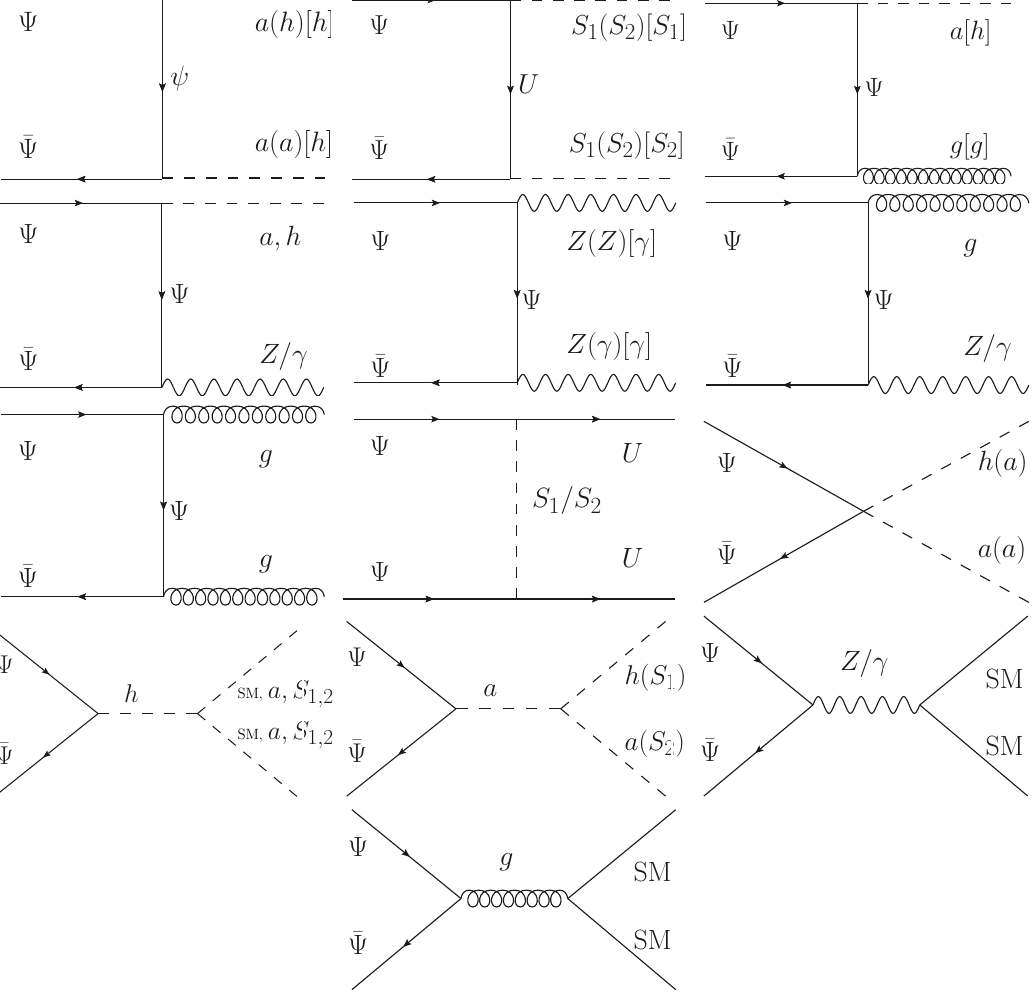
Figure 13. Annihilation channels of vectorlike quark Ψ . U denotes the SM up-type quark ( U ≡ u, c, t, ¯ u, ¯ c, ¯ t ).